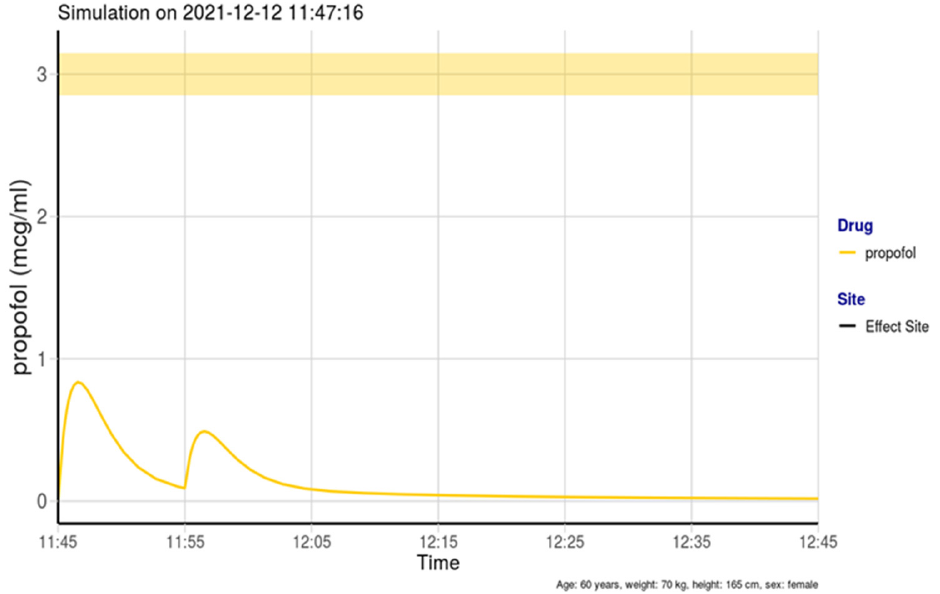
Figure 2. Example of predicted propofol concentration after an initial bolus of 20 mg, followed by a second bolus of 10 mg. Simulation performed with the Stanpump R shareware program (https://stanpumpr.io/ accessed on 12 December 2021).